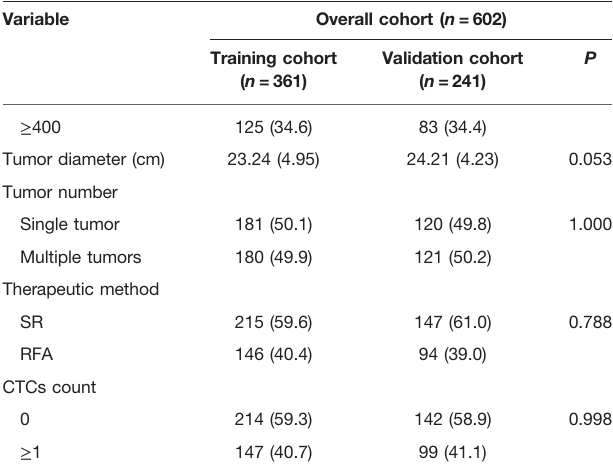
AST, aspartate aminotransferase; ALT, alanine aminotransferase; GGT, gamma glutamyl transpeptidase; ALP, alkaline phosphatase; Alb, albumin; TIBL, total bilirubin; DIBL, direct bilirubin; CR, creatinine; INR, international normalized ratio; AFP, alpha fetoprotein; HBV, hepatitis B virus; HCV, hepatitis C virus; RFA, radiofrequency ablation; SR, surgical resection. CTC, circulating tumor